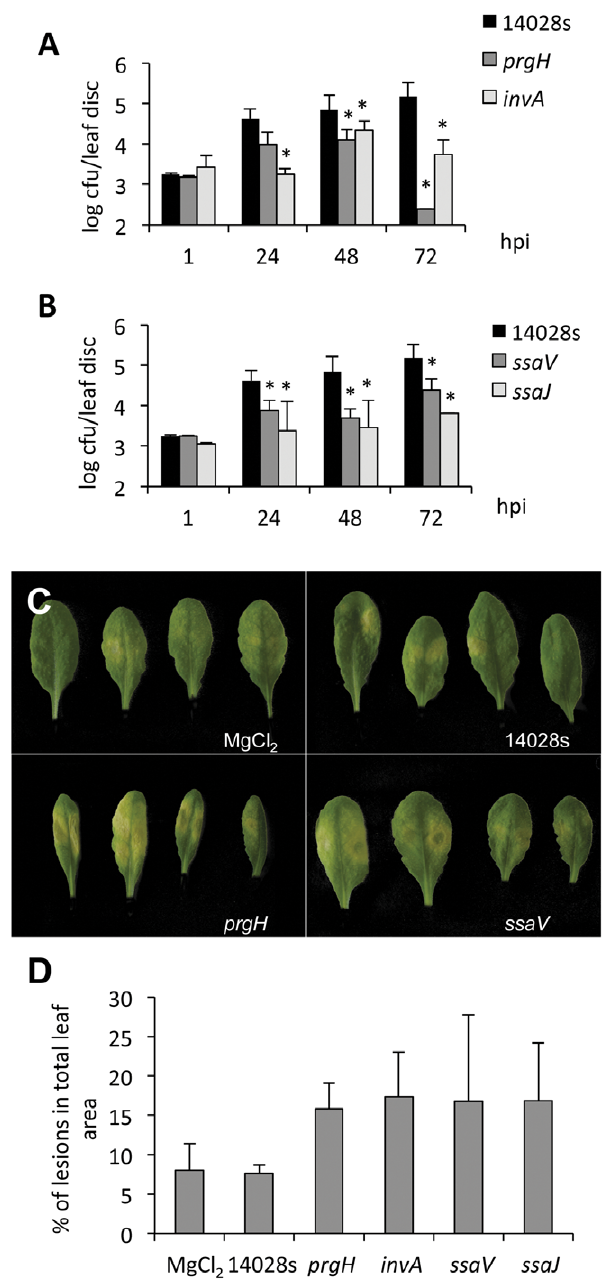
Figure 2. T3SS mutants of S. Typhimurium are less virulent for Arabidopsis plants. Four-week old Arabidopsis plants were syringe- infiltrated with bacterial solutions at OD 600 = 0.1 of wild-type S. Typhimurium 14028 s or T3SS mutants. A ; In planta proliferation of mutants in structural elements of SPI-1 encoded T3SS. B ; In planta proliferation of mutants in structural proteins of SPI-2 encoded T3SS. Leaf discs (0.7 cm 3 ) were harvested at 1–72 hours post infection (hpi). Serial dilutions were plated for cfu determination. * represents p , 0.05. C ; Symptoms on Arabidopsis leaves infiltrated with Salmonella mutants. Leaves were infiltrated with bacterial solution at OD 600 =0.1, photos were taken 2 days after infiltration. D ; Quantification of symptoms provoked by infiltration with T3SS mutants or wild type 14028 s bacteria. Analysis is performed with a color-based algorithm as described in